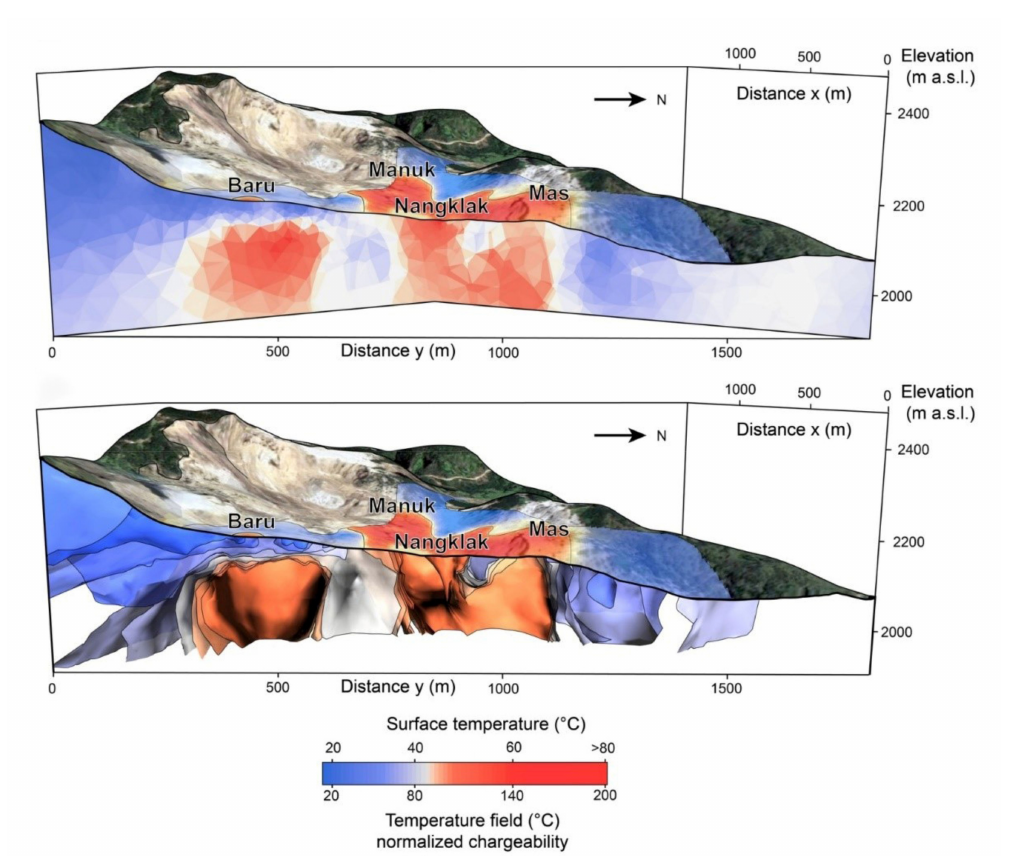
Figure 15. Detection of hydrothermal vents at Papandayan volcano (Indonesia). Tomography of the temperature field using the normalized chargeability determined from the induced polarization measurements and comparison with the surface temperature field. The normalized chargeability can be used to assess the position of the altered sub-volumes associated with the upwelling of the acidic hydrothermal fluids (“m a.s.l.” stands for meters above sea level) and the formation of kaolinite that is typical of